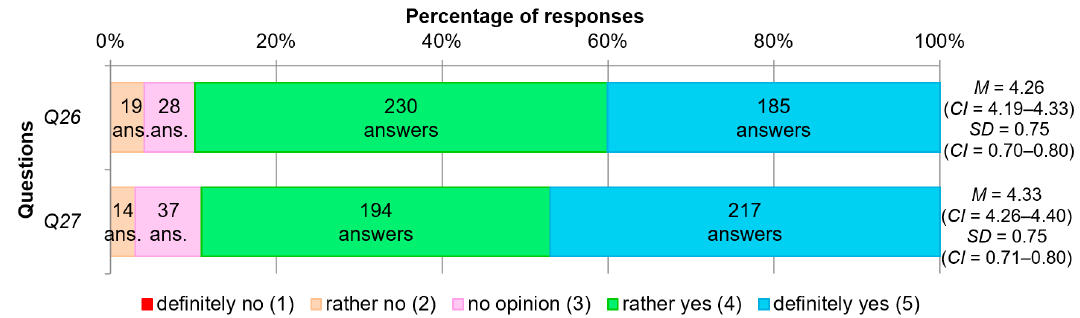
Figure 12. Assessment of social and hygienic factors influencing the choice of an alternative energy source for heating water in residential buildings ( M —average, SD —standard deviation, CI —confidence interval; questions numbers ( Q ) according to the Appendix A).